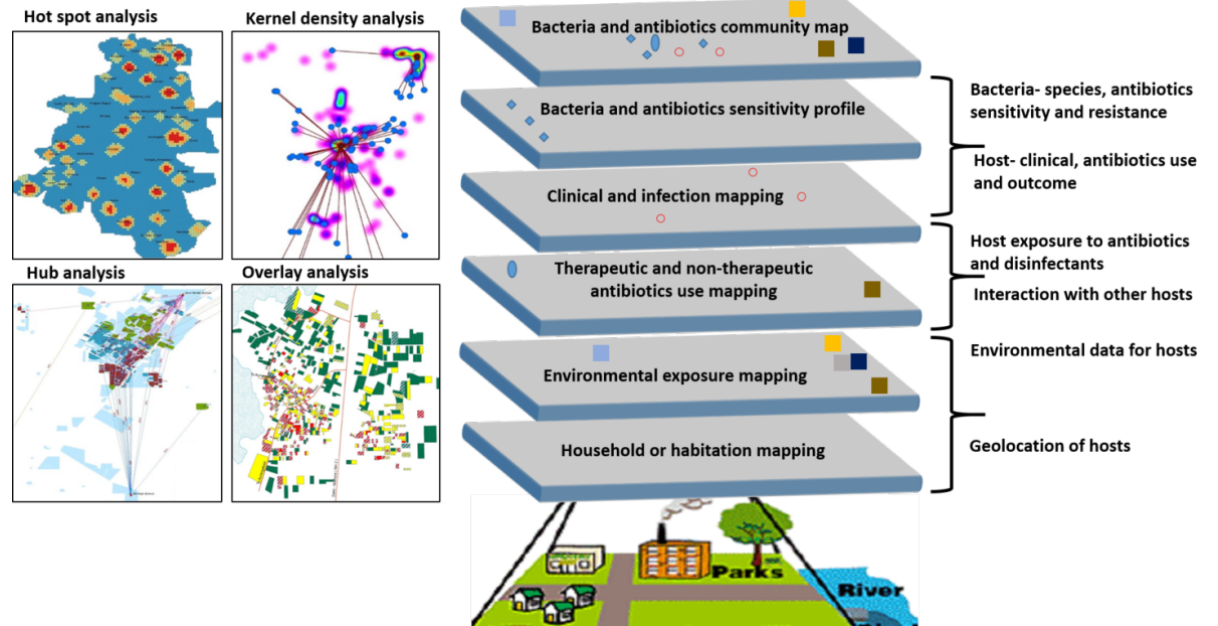
Figure 3. Proposed geospatial epidemiology analysis